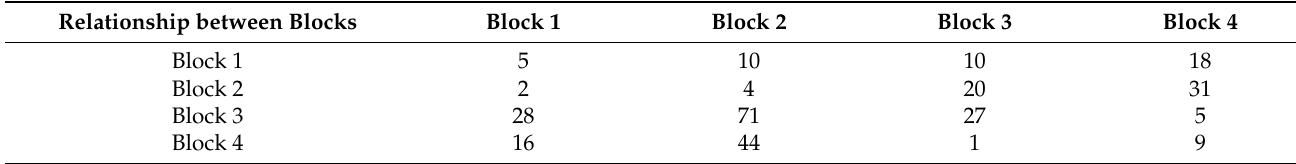
Table 7. Inter-block linkages of tourism eco-efficiency in the Yangtze River